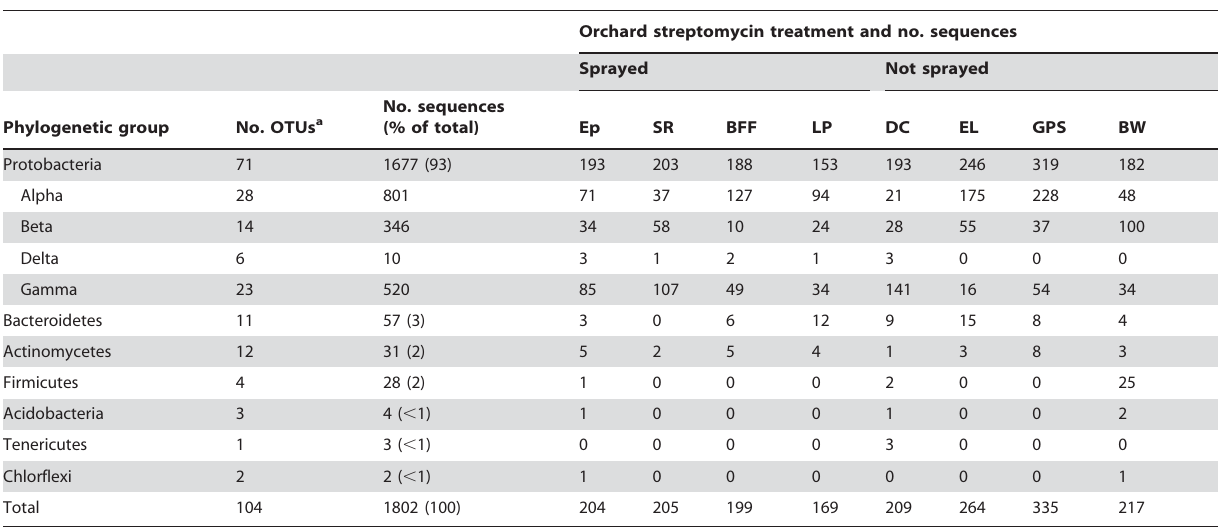
Table 4. Taxonomy and abundance of bacterial 16S rRNA gene sequences in libraries constructed from apple leaves from orchards differing in streptomycin treatment.